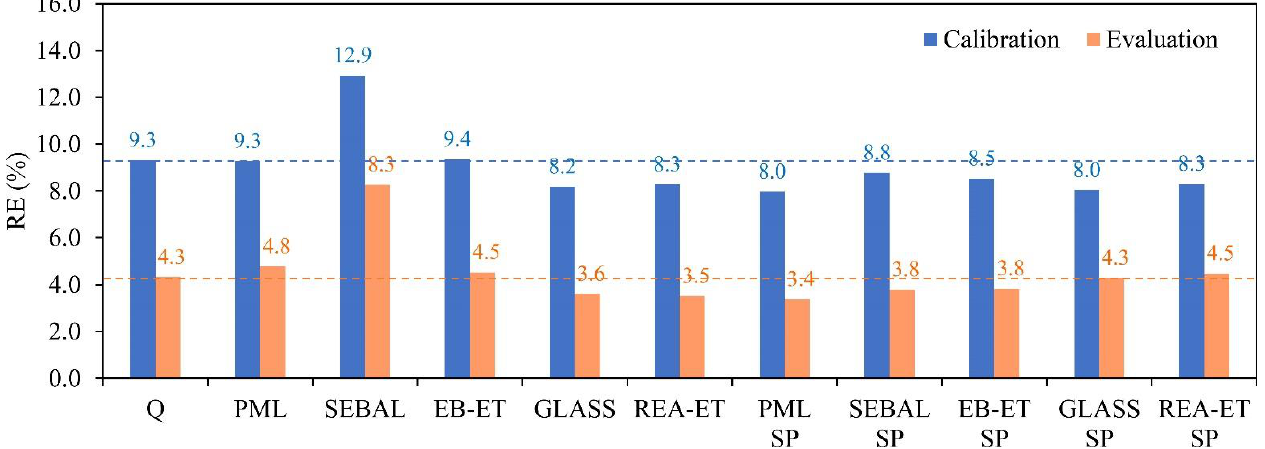
Figure 7. The relative errors of mean annual streamflow at the outlet from the benchmark scheme and calibration schemes on ET datasets in the calibration and evaluation periods.